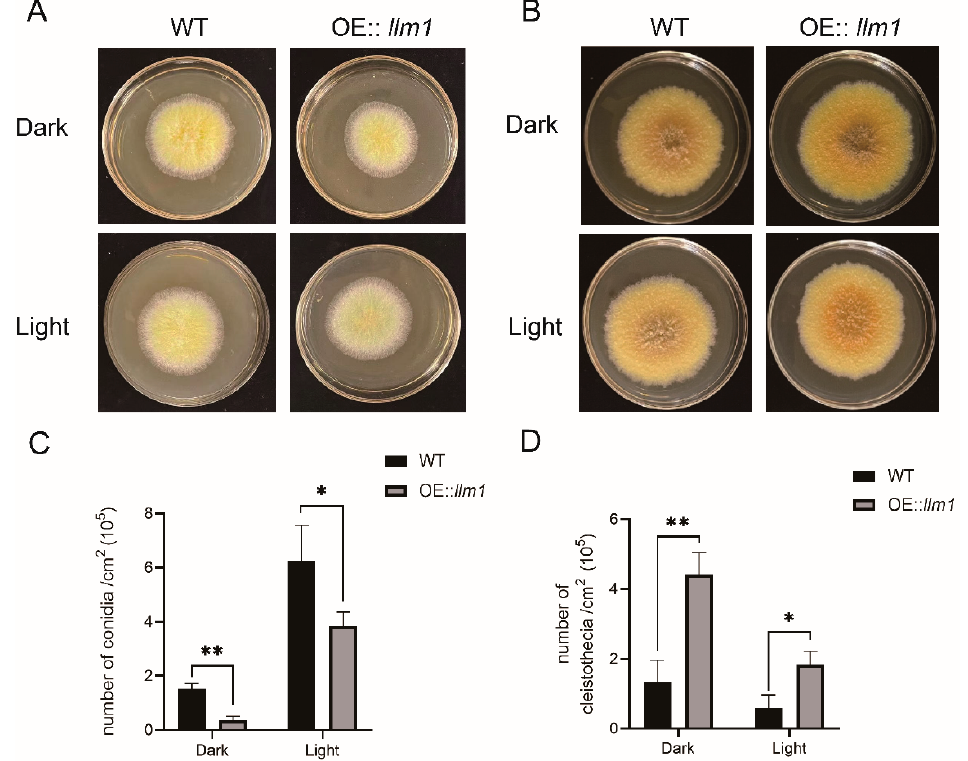
Figure 2. Effect of overexpression of llm1 on sex development of A. cristatus . ( A ) Colony morphology of WT and OE:: llm1 transformant on MYA plate with high sodium chloride concentration. ( B ) Colony morphology of WT and OE:: llm1 transformant on MYA plate. ( C ) Statistics of conidia number produced by WT and OE: llm1 transformant. ( D ) Statistics of cleistothecia number produced by WT and OE: llm1 transformant. Experiments were conducted in three replicates. Standard deviations are indicated with error bars. Values that differed significantly from the value for the WT according to the t -test are indicated with asterisks (* p < 0.05, ** p < 0.01).